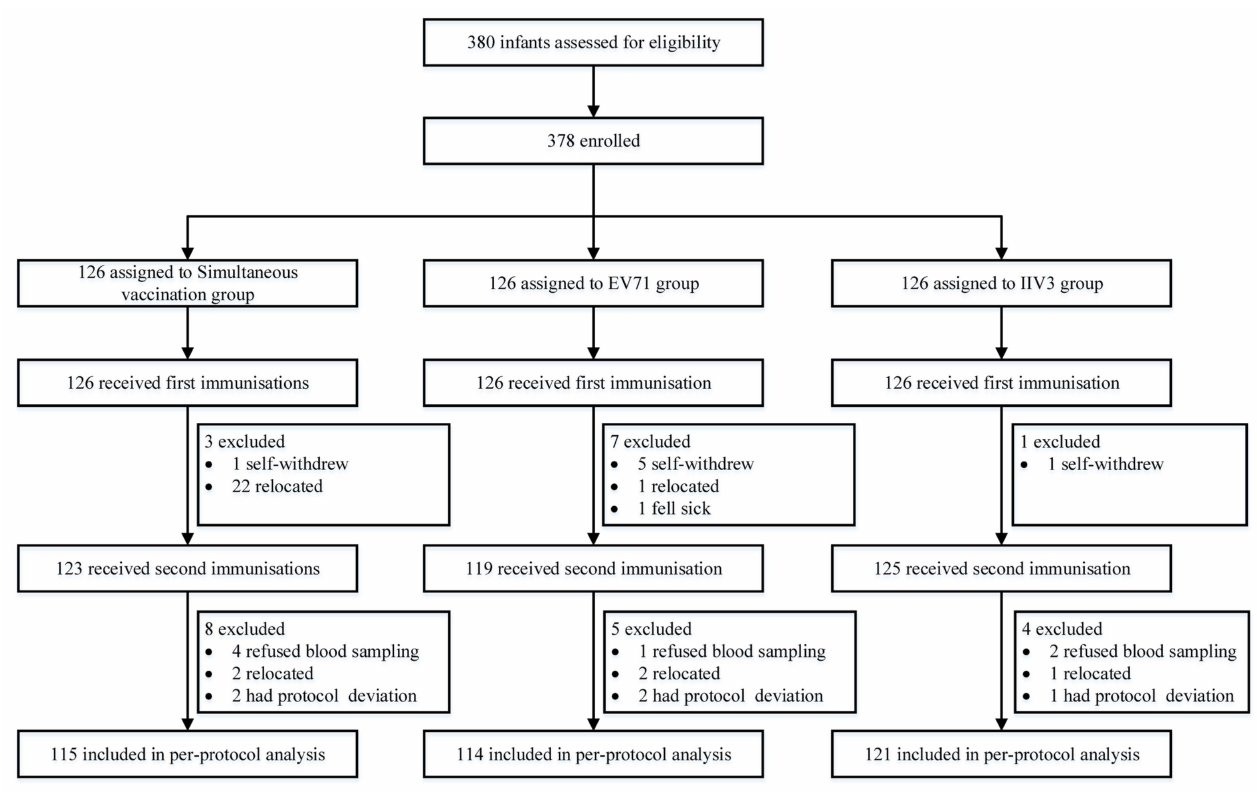
Figure 1. Trial profile. EV71 = inactivated enterovirus 71 vaccine. IIV3 = trivalent split-virion inactivated influenza